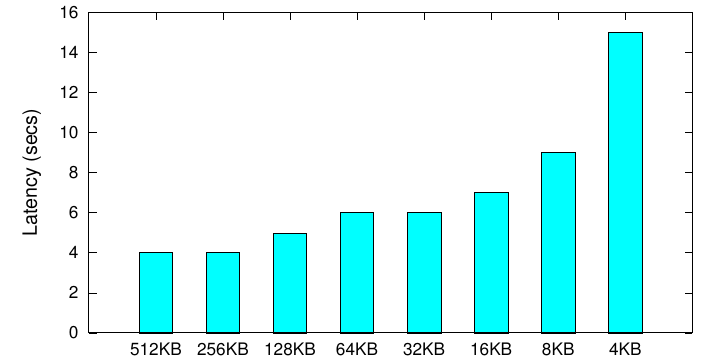
Figure 5. Latency of 4 GB storage write varying the write size.